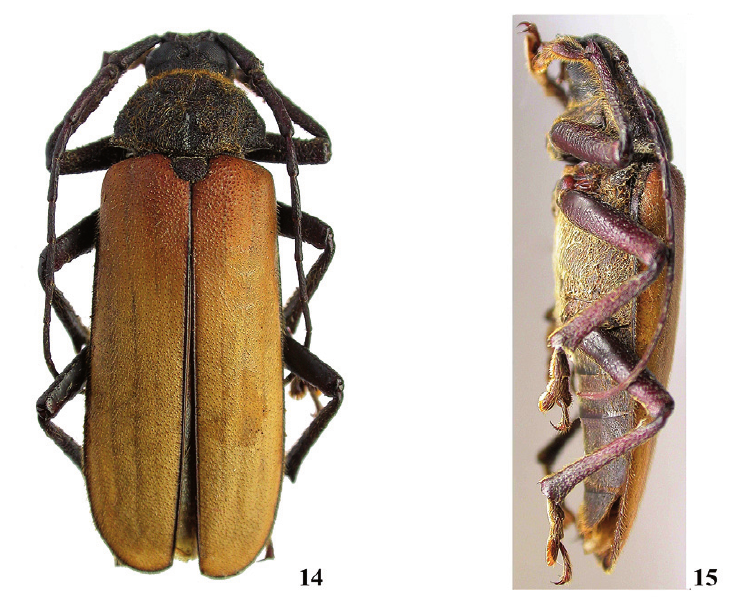
Figures 14–15. Strongylaspis boliviana , male habitus: 14 dorsal 15 Head longitudinally deeply sulcated between upper ocular lobes; punctation coarse, very abundant, confl uent between upper ocular lobes and occiput; sparser on antennal tubercles near clypeus, and confl uent near upper ocular lobes. Frons and clypeus coarsely, confl uently punctate. Antennal tubercles closer at base; apex rounded. Mandible short (ca. 1/3 of length of head); dorsal carina low, wide, not well marked; latero-outer face with projection near median region (boundary between dorsal punc- tate and smooth areas); pilosity moderately long and abundant on dorsal face. Hypos- tomal area coarsely, confl uently punctate; pilosity moderately sparse. Gula coarsely punctate (punctures closer near hypostomal area, sparser towards prothorax). Anten- nae (Figs 14, 15) reaching posterior third of elytra. Scape slightly longer than anten- nomere III; coarsely, abundantly punctate on dorsal face (punctures confl uent on basal 2/3). Antennomere III slightly shorter than IV-V together; coarsely, confl uently punc- tate on basal half, sparser in remaining portion. Prothorax transverse, convex with disc almost fl at; anterior angles not projected forward; posterior angles with spine, directed upward and backward. Pronotal surface densely rugosely punctate; disc with “M”-like depression at anterio-central portion; pos- terio-central region with transversal depression at each side of longitudinal depression that begins at base and reaches almost to middle; pilosity long, moderately abundant. Prosternum strongly elevated at central area; pilosity on prosternum, proepisterna, and proepimera moderately long and abundant. Prosternal process somewhat wide, longitu- dinally, slightly sulcated on basal half; fi nely, abundantly punctate on basal half; coarsely, confl uently punctate on apical half; pilosity long and abundant; apex rounded, project-